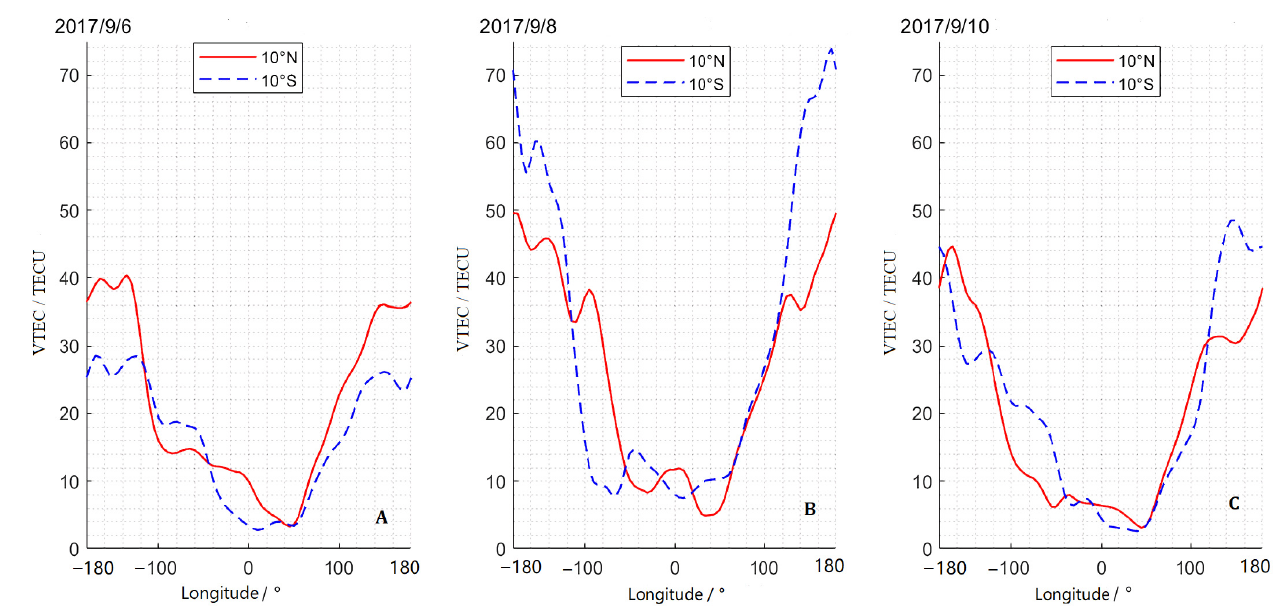
Figure 5. Fluctuation characteristics of VTEC on 10° N/S latitudes at UTC 2:00. The blue dotted line and the red solid line represent the southern and northern hemisphere VTEC, respectively, unit: TECU. Panels ( A – C ) show the VTEC characteristics of the pre-, mid- and post-geomagnetic storm phases, respectively.